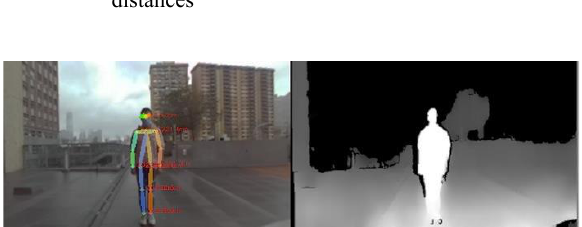
Figure 8. A person stands still while in front of the camera to enable the distance value of the waist to be